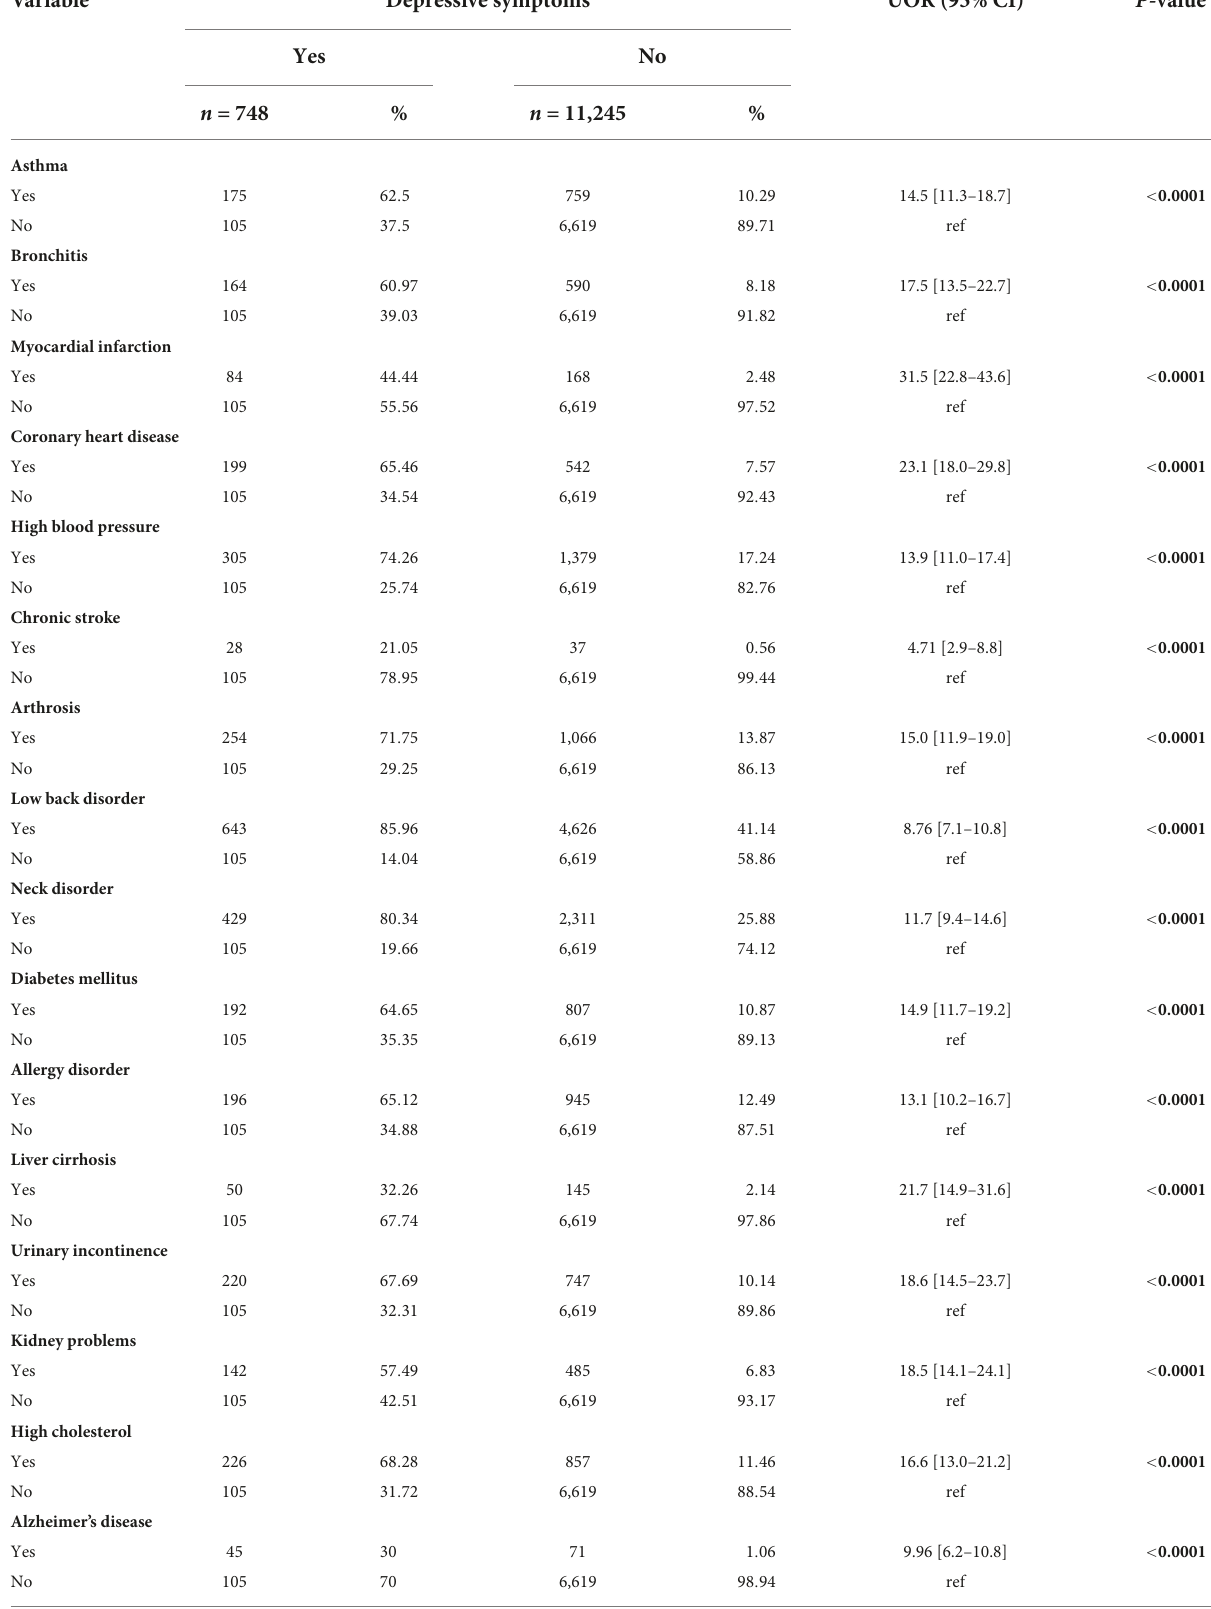
TABLE 2 Distribution of diseases conditions by depressive symptoms. Variable Depressive